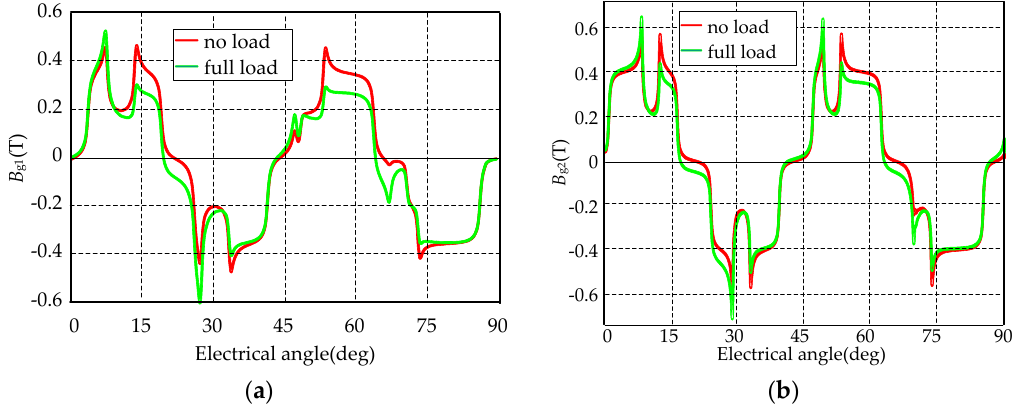
Figure 7. The air gap flux densities at no load and full load: ( a ) The inner air gap flux densities; ( b ) The outer air gap flux densities.